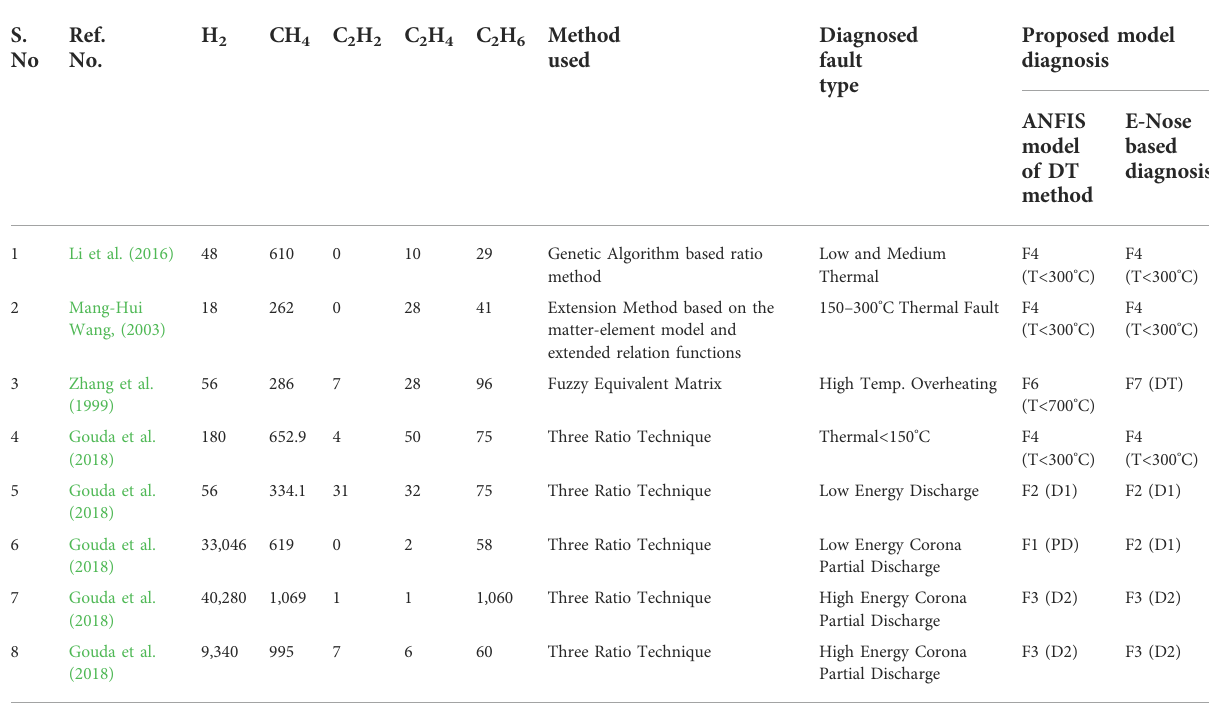
TABLE 6 Impact of noise on incipient fault diagnosis.